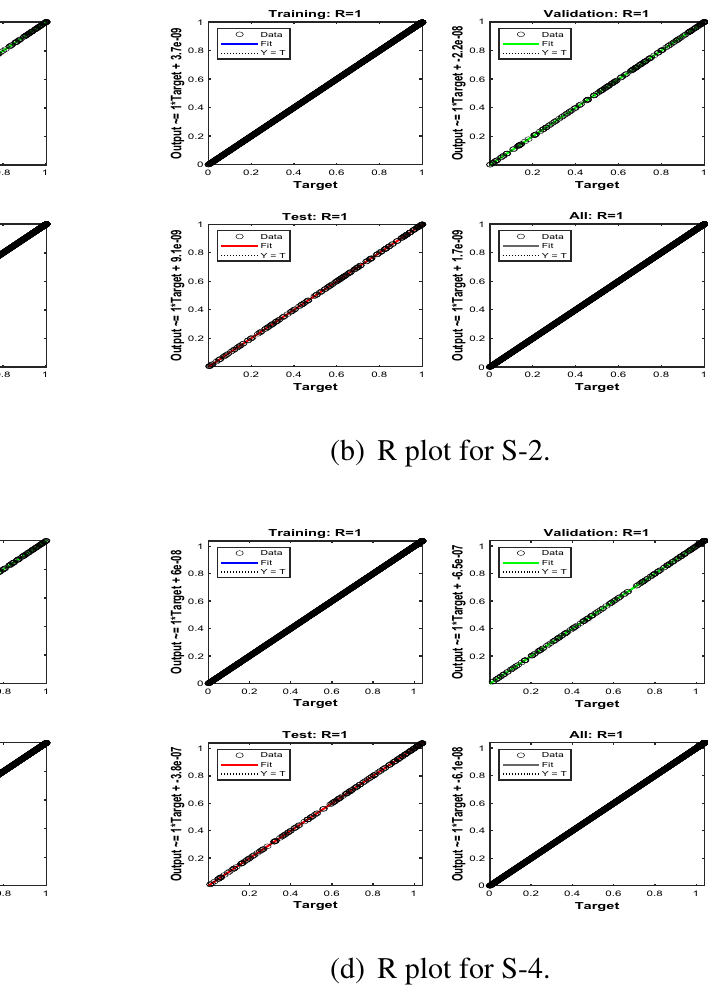
Figure 9. Regression (R) analysis of LMA-TNN for Case 2 in constant